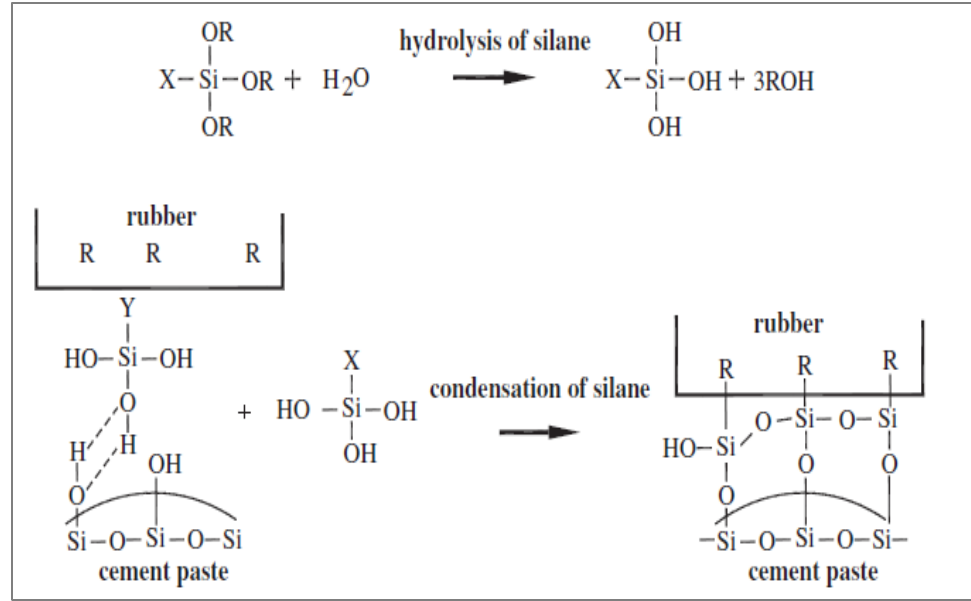
Figure 17. Mechanism of silane coating agents [105]: used as per Elsevier permissions.